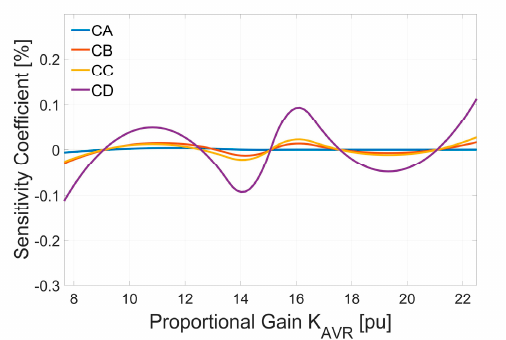
damping ξ e (TNF 1 ) related to K AVR .